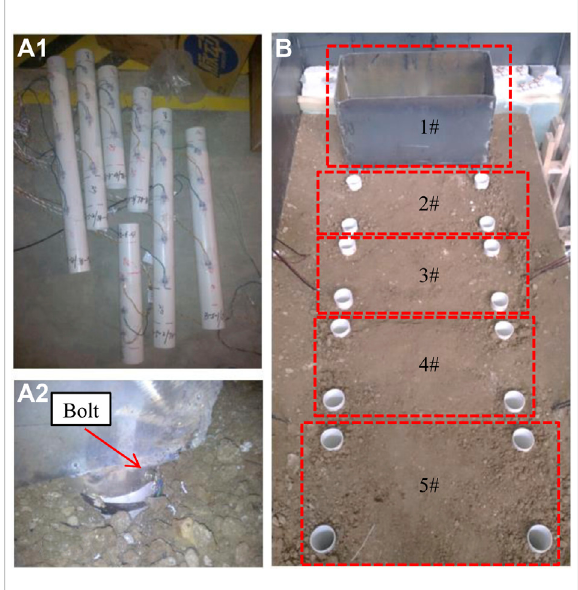
FIGURE 3 Model piles used in thetest: (A1) different piles; (A2) details of connection between containers and piles; (B) layout of